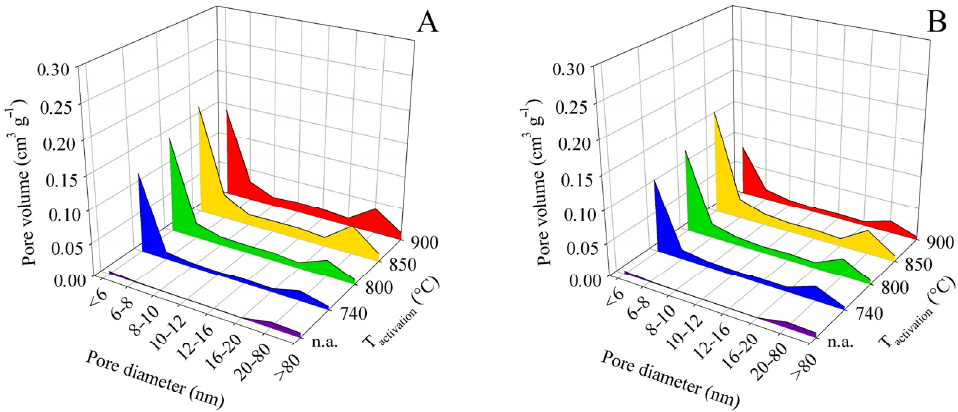
Figure 6. Changes in pore size distribution in dependence on activation conditions applied to the solid residue obtained by pyrolysis up to 850 °C for series ( A , B ).